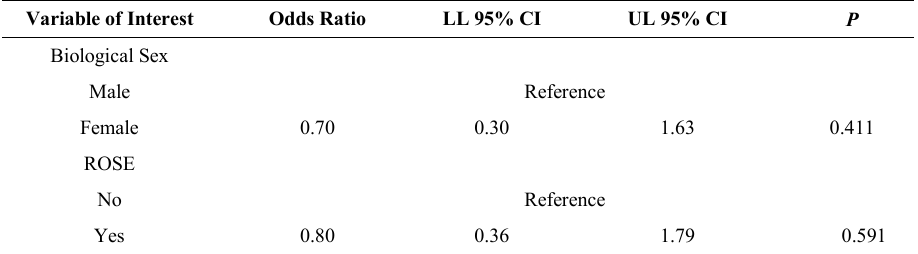
Table 2. Multivariable Mixed Effects Binary Logistic Regression for Prediction of Adequacy